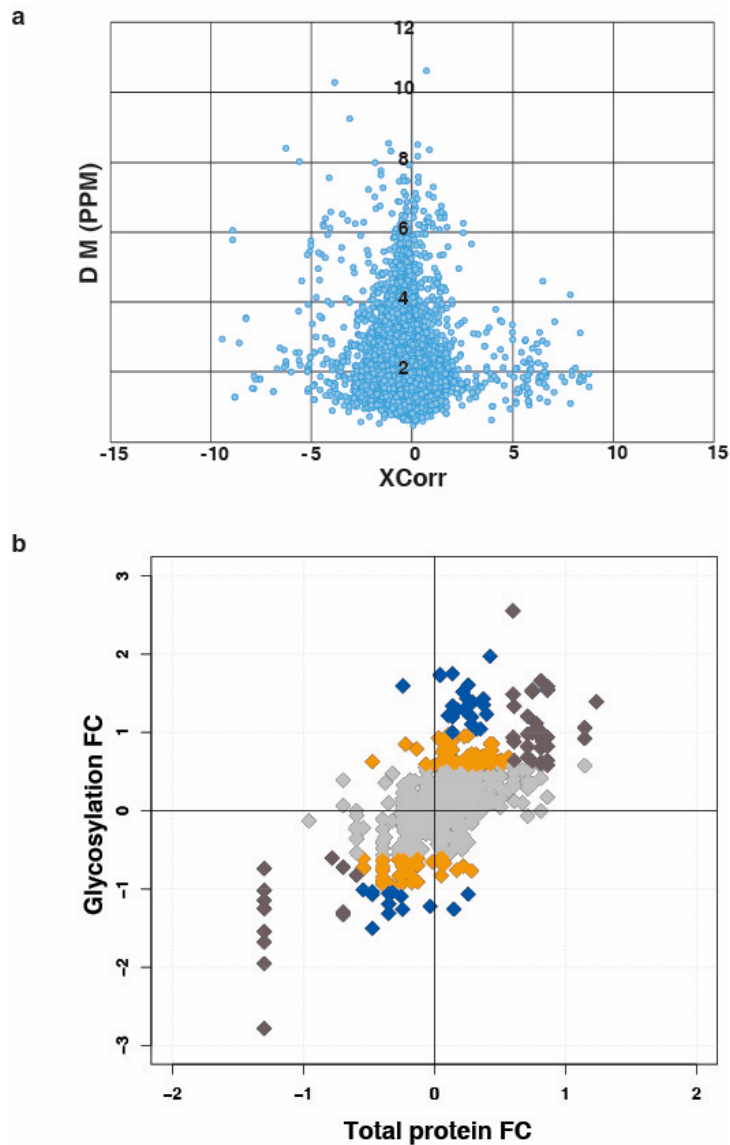
Figure 2. ( a ) Distribution of the mass error from the parent ion measurement against the SEQUEST Xscore; ( b ) global presentation of proteomic and respective glycosylation occupancy. Yellow datapoints represent di ff erential glycosylation occupancy with fold change ≥ 1.5 and blue datapoints with fold change ≥ 2 on proteins that are unchanged in proteomic data. Brown datapoints represent proteins and glycosylation occupancy with similar dysregulation pattern (overexpressed / increased glycosylation occupancy and / or downregulated / reduced glycosylation occupancy). Grey datapoints represent proteins that are unchanged in both